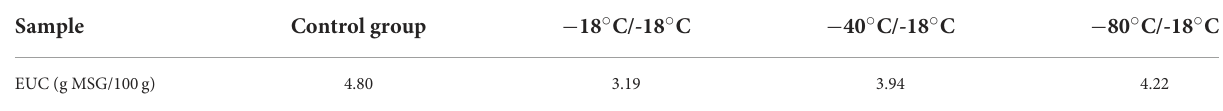
TABLE 7 EUC of HGM with different freezing